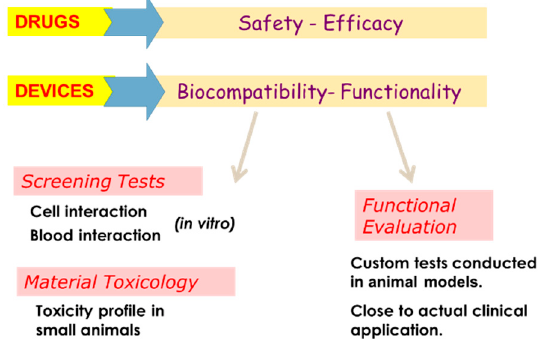
Figure 8. Preclinical evaluation of drugs and devices.